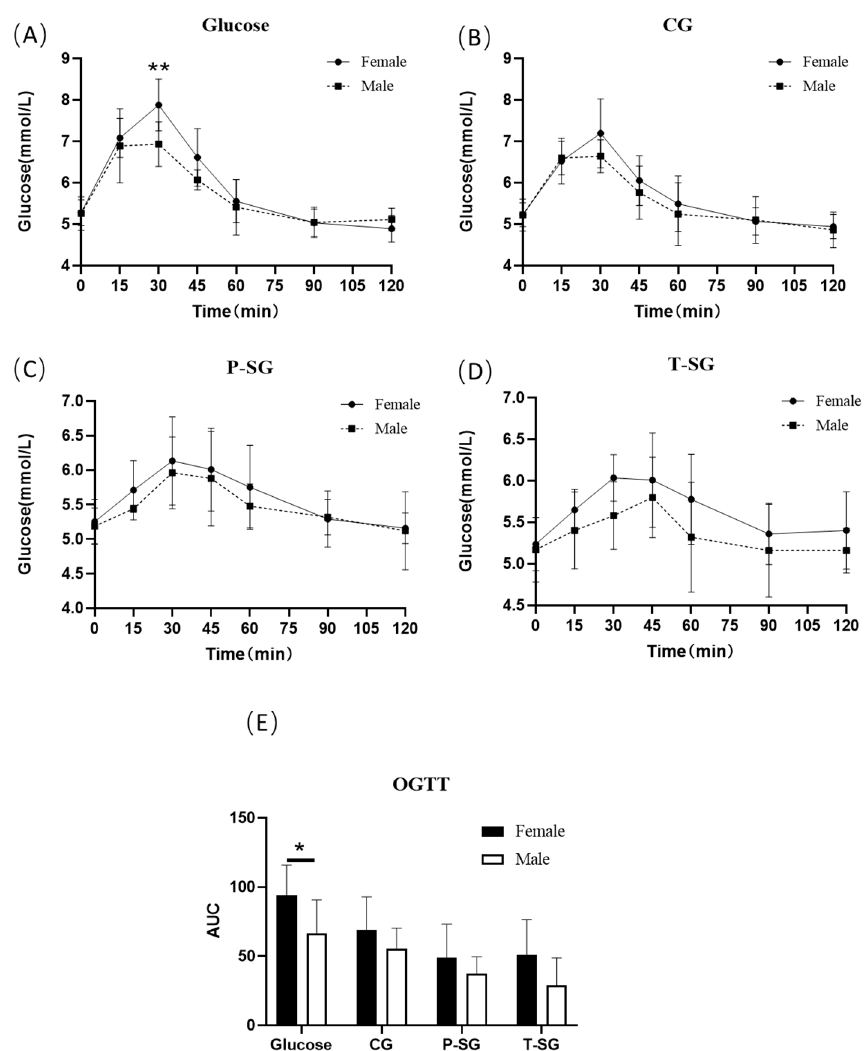
Figure 2. OGTT curve ( A – D ) and OGTT AUC ( E ) of males and females after consumption of a 10 g